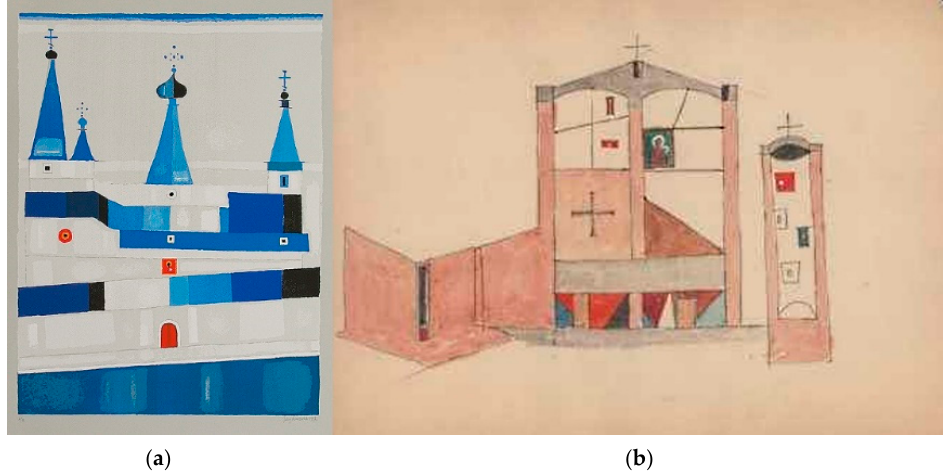
Figure 7. Jerzy Nowosielski: ( a ) “Church”, 1997 color serigraphy. Photography by M. Gardulski/Galeria Starmach. Reproduced with permission. ( b ) Project of the church in Sochaczew. Color scheme of the facade, 1958. Museum of Academy of Fine Arts, Warsaw. Reproduced with permission.